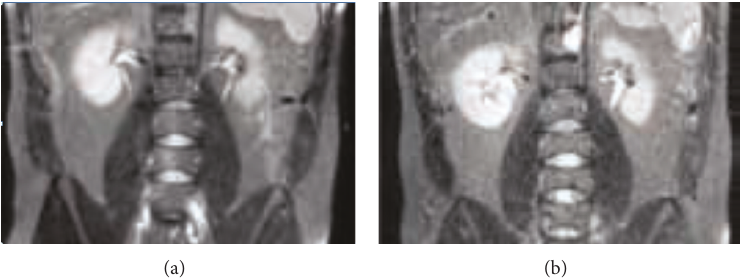
Figure 3: 3T system showing up to 40% improvement in SNR with direct digital (a) and signal loss resulting from digitization performed away from the coil